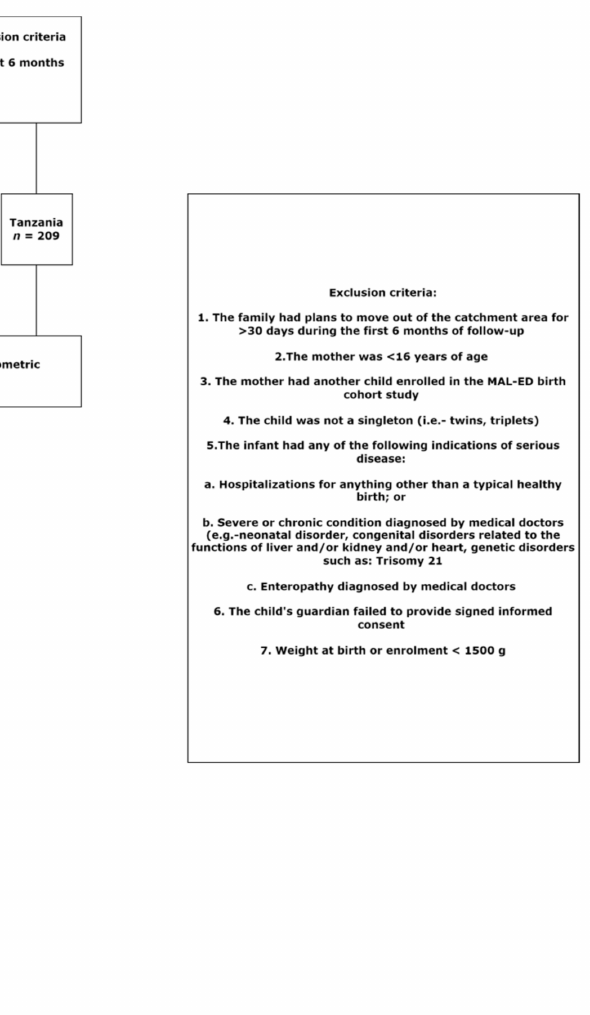
Figure 1. Workflow of the